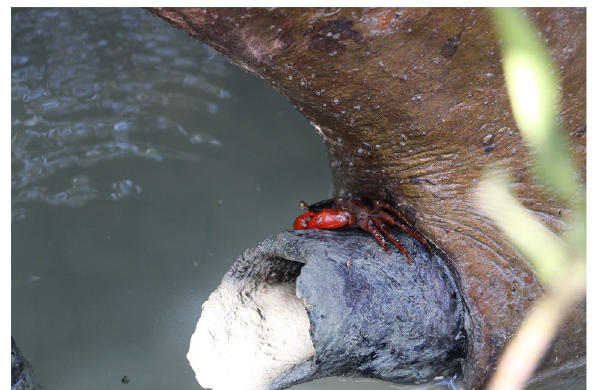
Figure 3. Photograph of Metopograpsus cannicci in its natural habitats in the Gulf of Oman. Photo by Reza Naderloo.